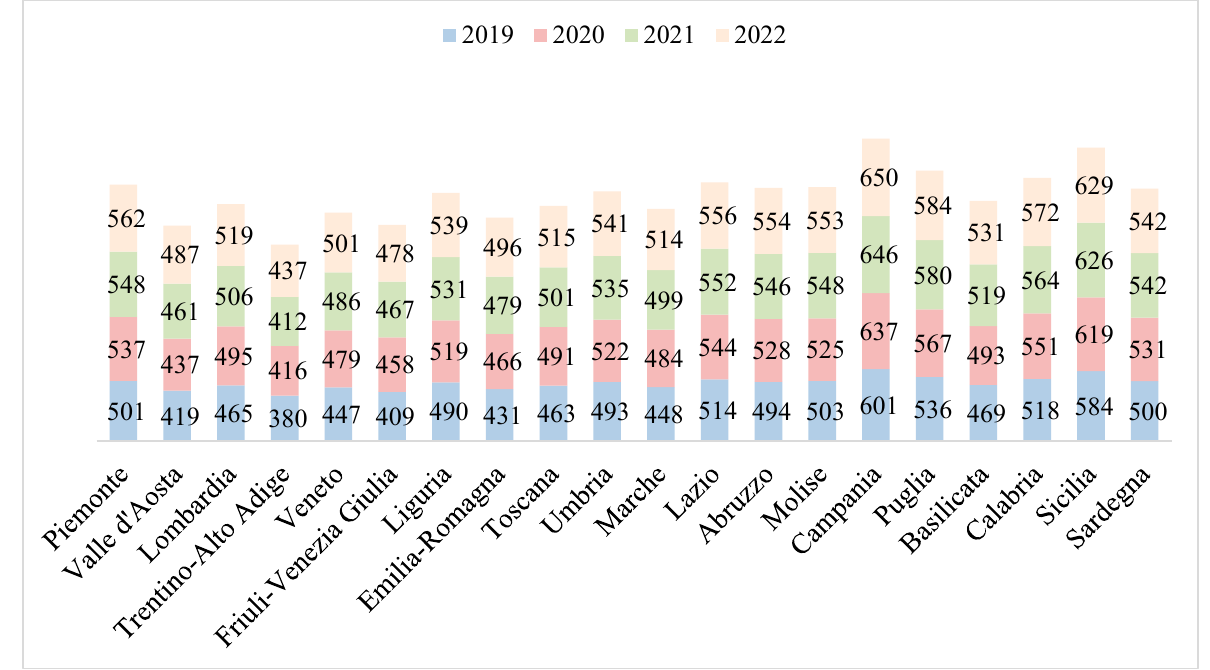
Figure 13. RdC per average monthly amount (in euros), by regions, 2019–2021. Source: own elaboration on the INPS database.